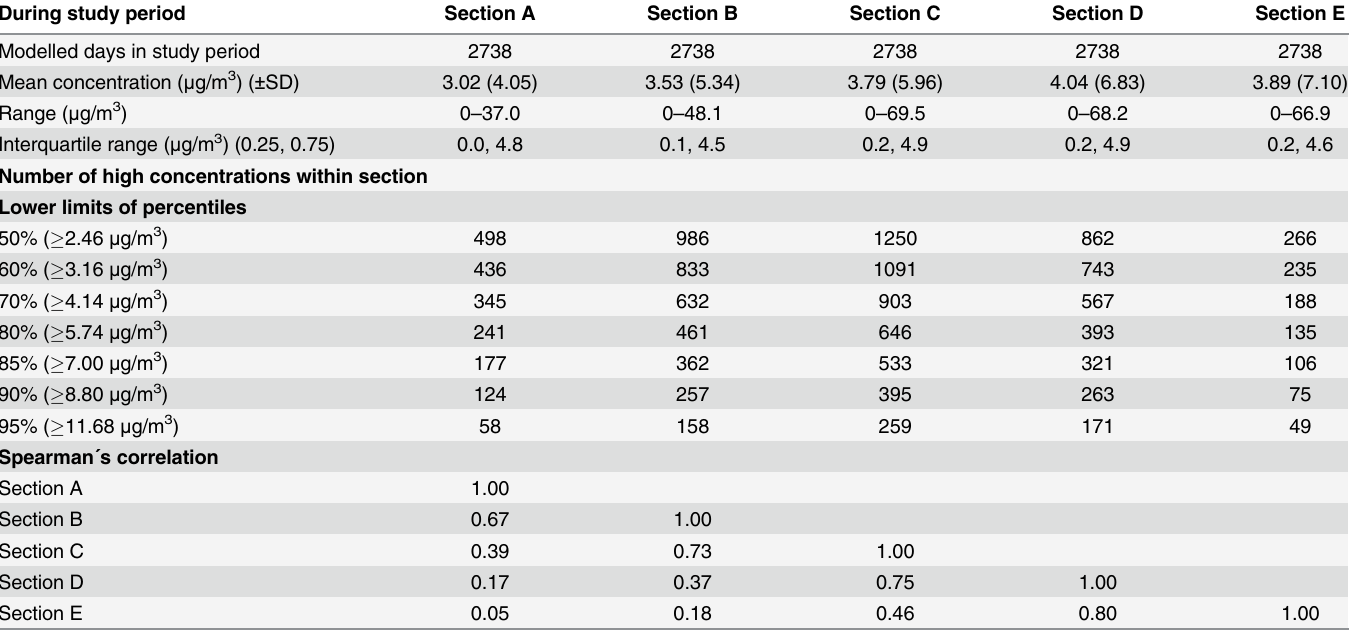
Table 2. Descriptive statistics of modelled daily 24-hour concentrations of H 2 S during study period in each section of the Reykjavik capital area, daily count of higher concentration in each section and percentiles, as well as Spearman´s correlation of daily 24-hour concentrations of H 2 S between